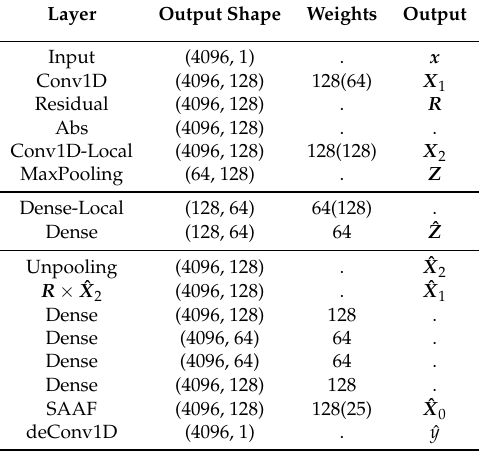
Figure 1. Block diagram of CAFx ; adaptive front-end, synthesis back-end and latent-space DNN. Table 2. Detailed architecture of CAFx with an input frame size of 4096